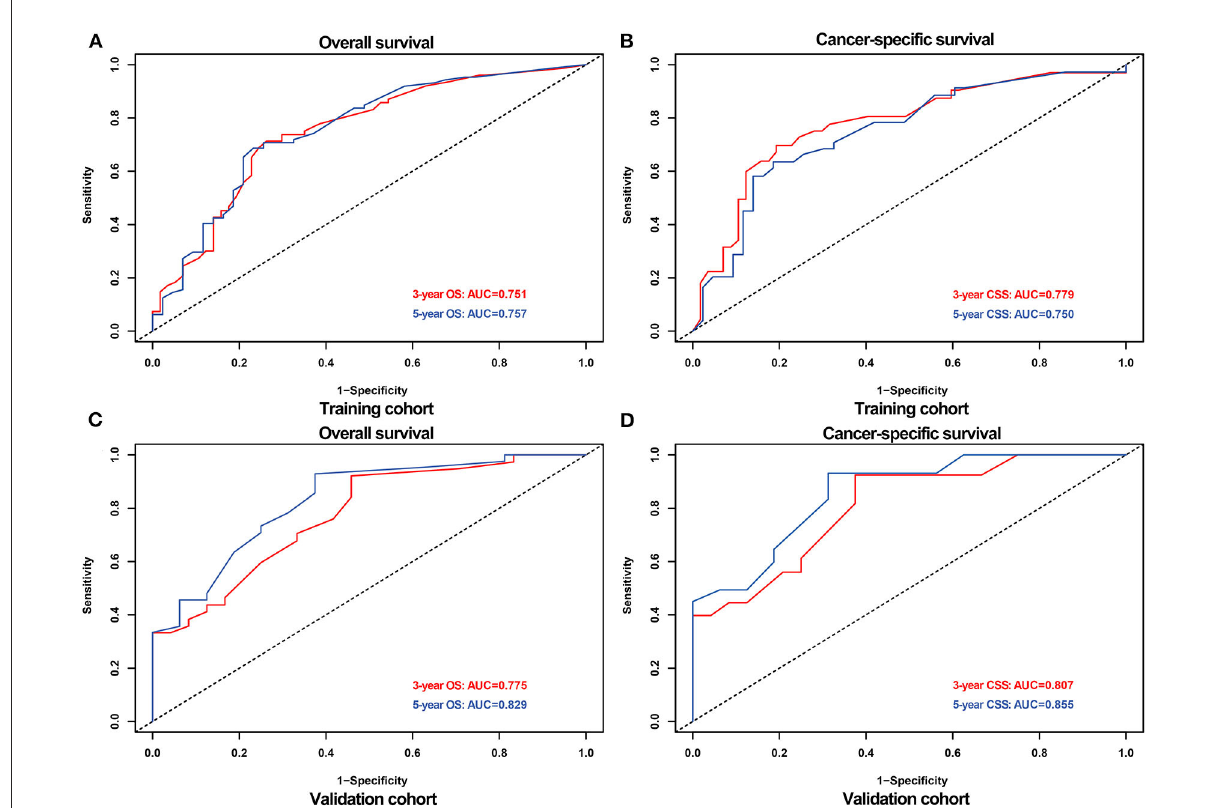
FIGURE4 ROC curves for predicting 3-,5- OS and CSS probabilities in the training and validation cohort. ROC for 3-,5- OS (A) and CSS (B) in the training cohort; ROC for 3-,5- OS (C) and CSS (D) in the validation cohort.